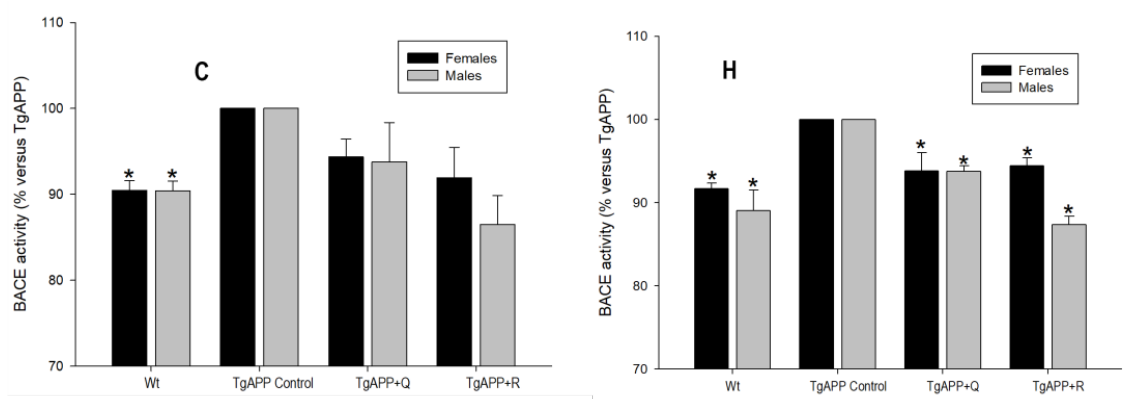
Figure 6. Effect of quercetin (Q) and rutin (R) on BACE1 activity in the Cortex (C) and the Hippocam- pus (H). (1) WT; (2) TgAPP control; (3) TgAPP + Q; (4) TgAPP + R. * p < 0.05 vs. TgAPP control (ANOVA followed by the post-hoc Newman–Keuls multiple comparison